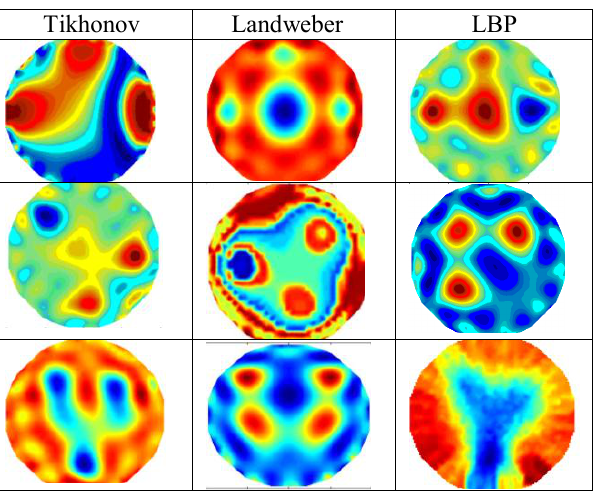
Fig. 1 is a flowchart for our proposed method.